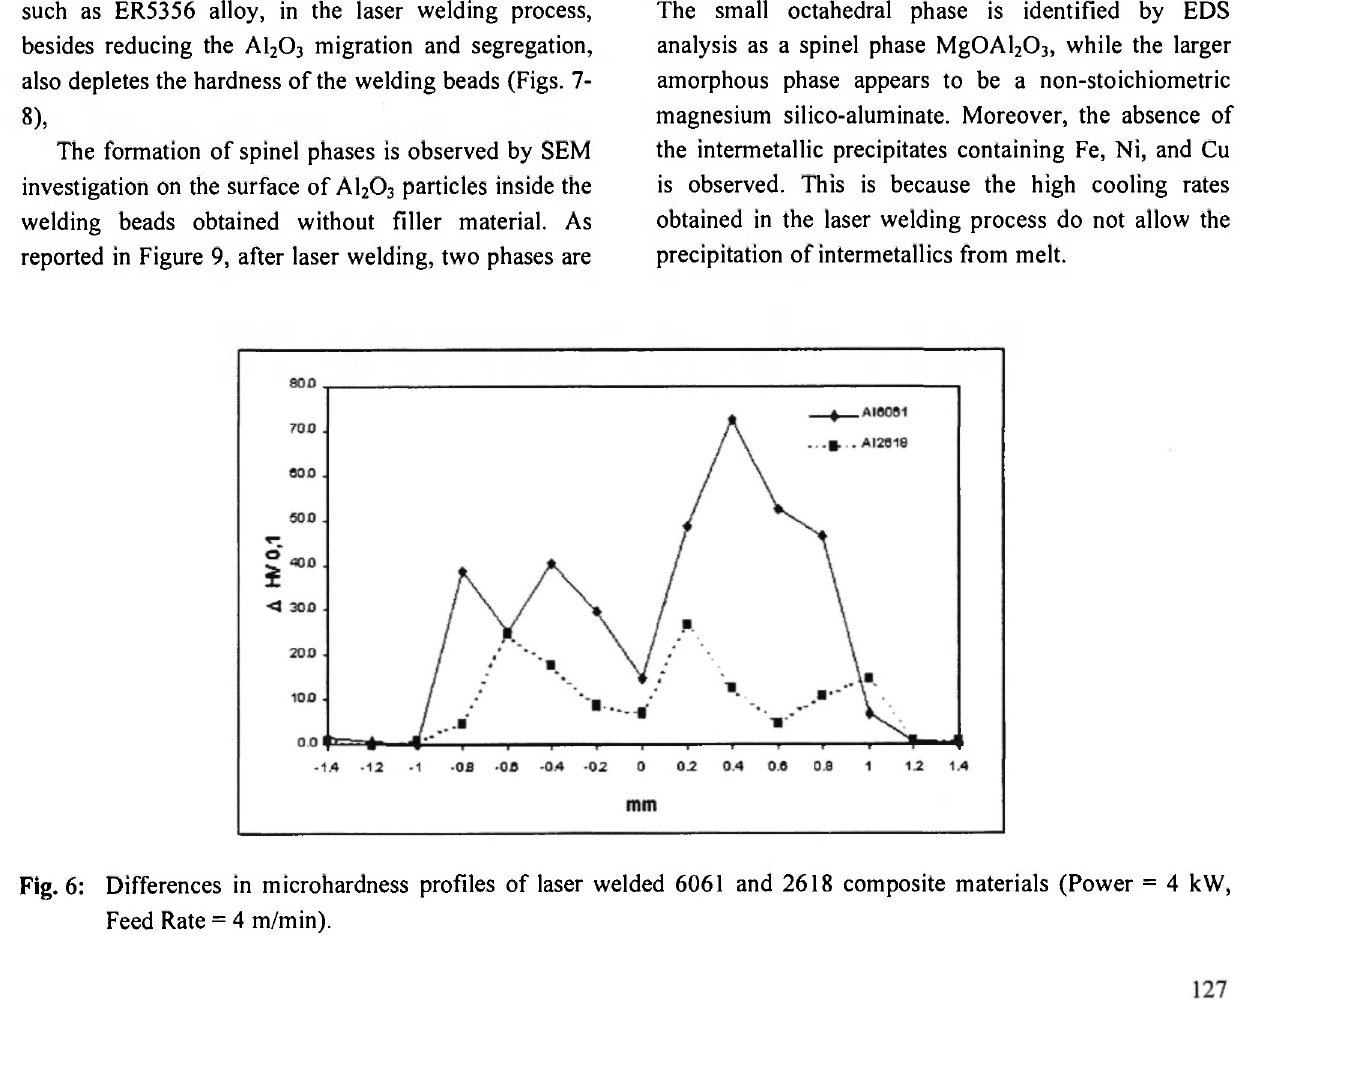
Fig. 7: Weld bead of 6061/20% A1 2 Ü 3 composite material joined with ER5356 filler material (Power = 4 kW, Feed Rate =4 m/min).